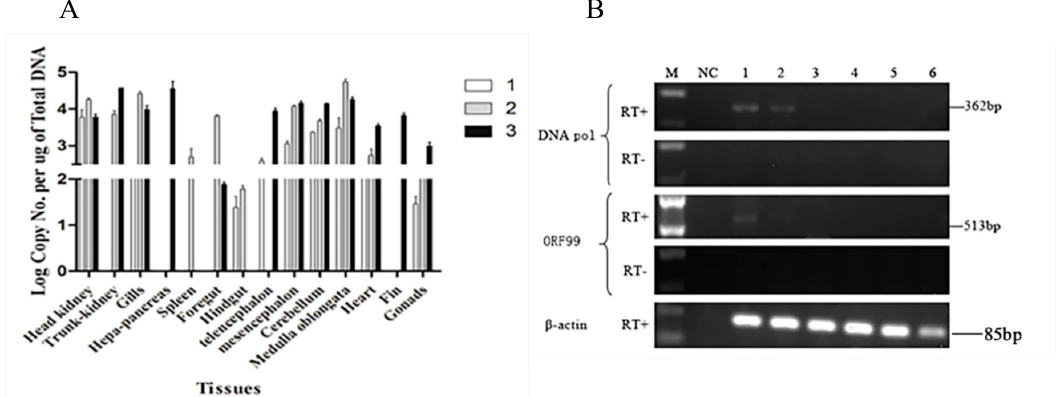
Figure 2. Detection of CyHV-2 DNA and gene transcription in the moribund fish from temperature stress: ( A ) Quantification of the CyHV-2 DNA from three moribund fish suffered temperature stress by qPCR. White (1), gray (2), and black (3) bars respectively represent the different moribund fish. CyHV-2 DNA copies were calculated similarly, as described in Figure 1. The DNA copies shown are the mean of triplicates ± SD. ( B ) RT-PCR analysis of total RNA harvested from moribund fish in the presence (RT+) or absence (RT-) of reverse transcriptase: The amplicons of DNA pol (362 bp) and ORF99 (513 bp) are indicated. Lanes 1 to 6 respectively represent the tissue of the head, kidney, gills, midbrain, medulla oblongata, heart, and spleen, which were sampled from the same fish. The amplicons of β -actin gene are used as an internal control to ensure that comparable levels of input RNA were used in RT-PCR. One representative fish of three is shown.